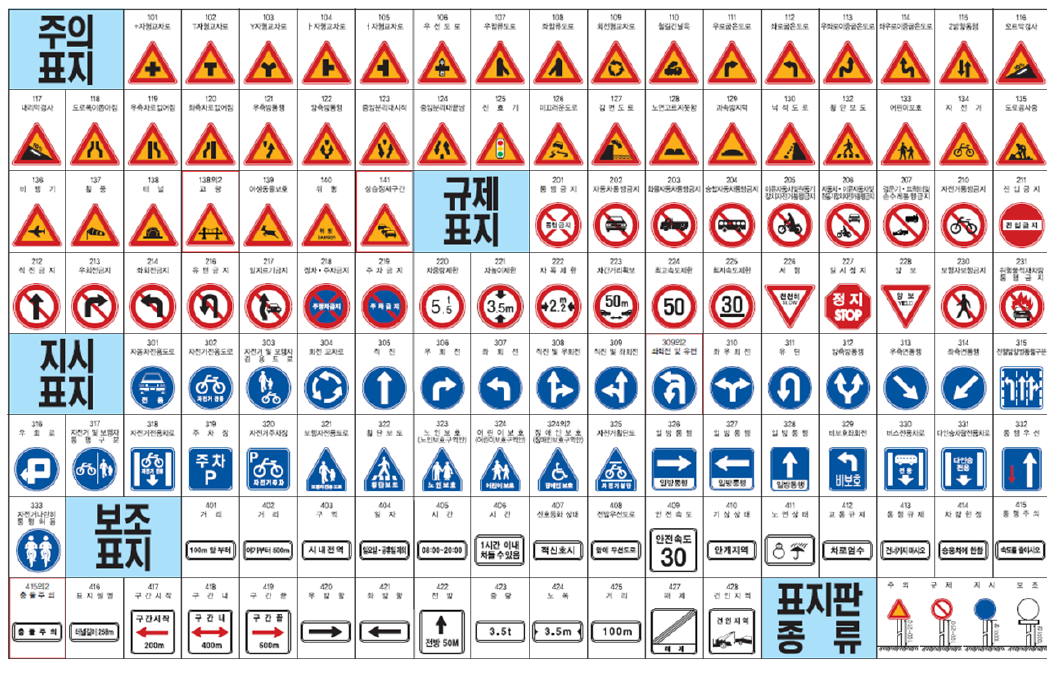
Figure 1. Traffic signs in Korea [31].